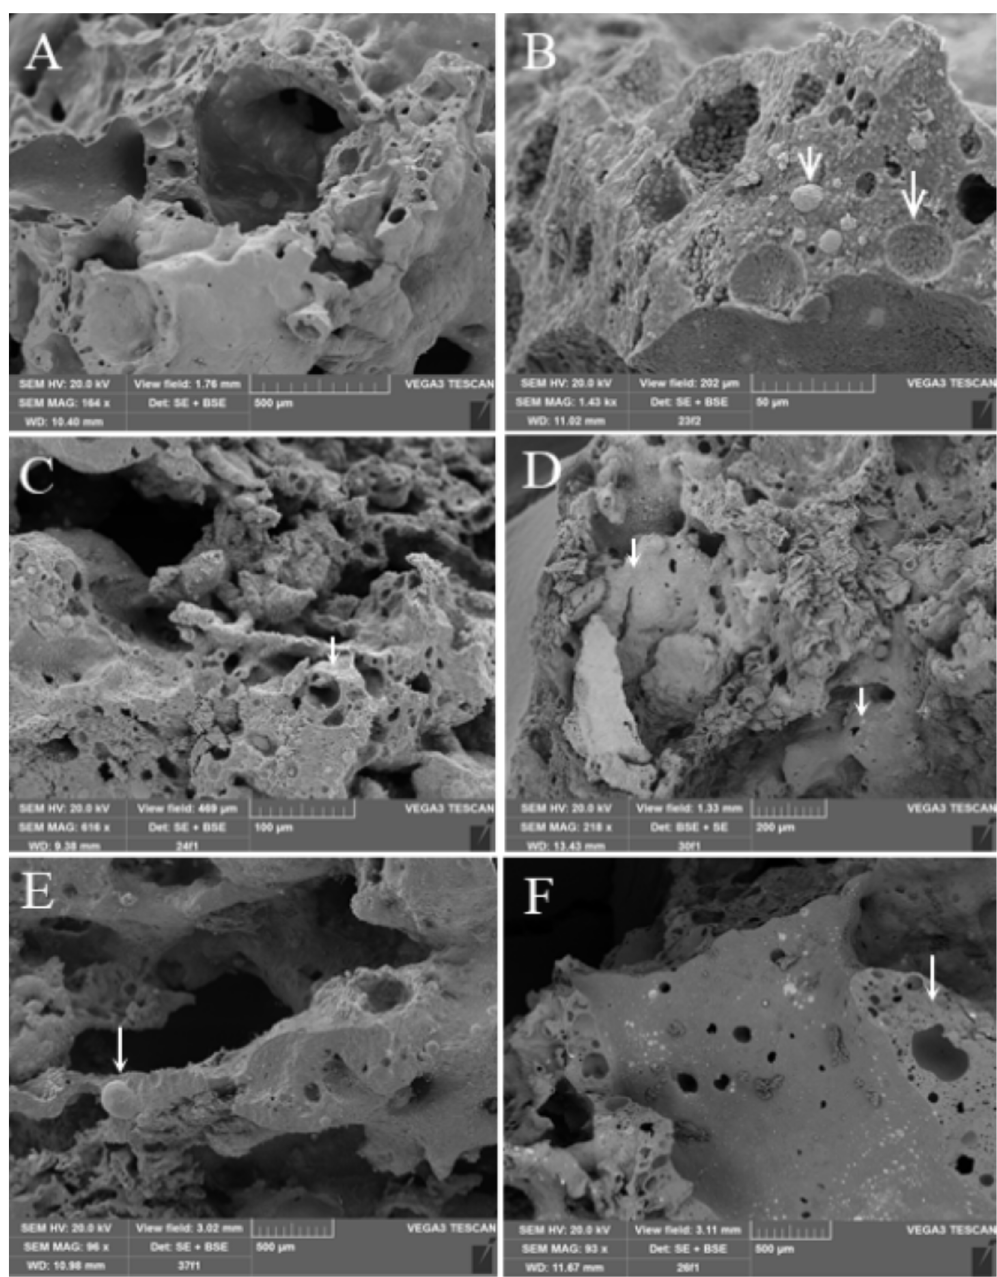
Figure 1. SEM microphotographs of SHS-treated pellets. ( A ) Scoriaceous texture. ( B ) Detail of A. Granular forsterite and wüstite pave the bubble cavities and globular metallic iron drops, suggesting that the T melting of iron was attained. ( C ) Blocky, vesicular texture. ( D ) Scoriaceous texture showing an outer silicate shell (dark grey), including an inner metallic layer (light grey, arrow on the left). The arrow on the right indicates the inter- growth of globular metallic Fe within olivine. ( E ) Large globular metallic iron drop. ( F ) Scoriaceous texture of wüstite + forsterite, including irregularly scattered globular iron